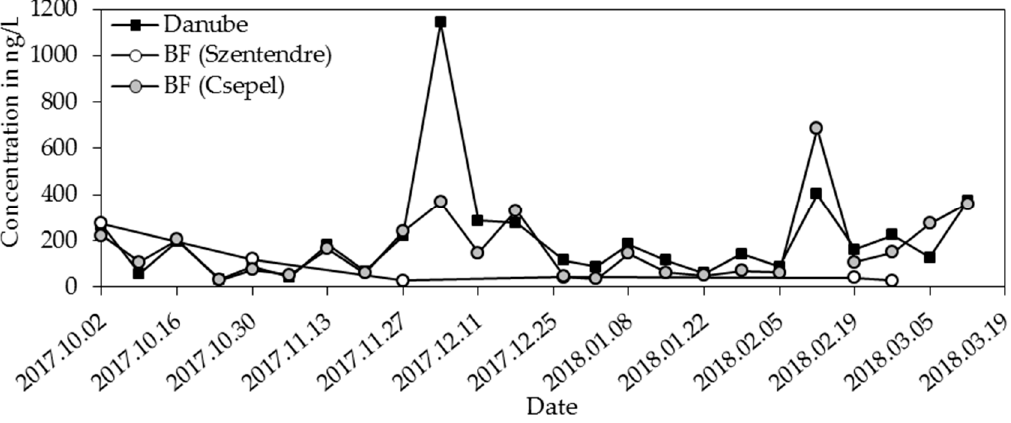
Figure 6. Seasonal fluctuation of metazachlor-ESA concentrations in the Danube River water (squares) and bank filtrate (circles).